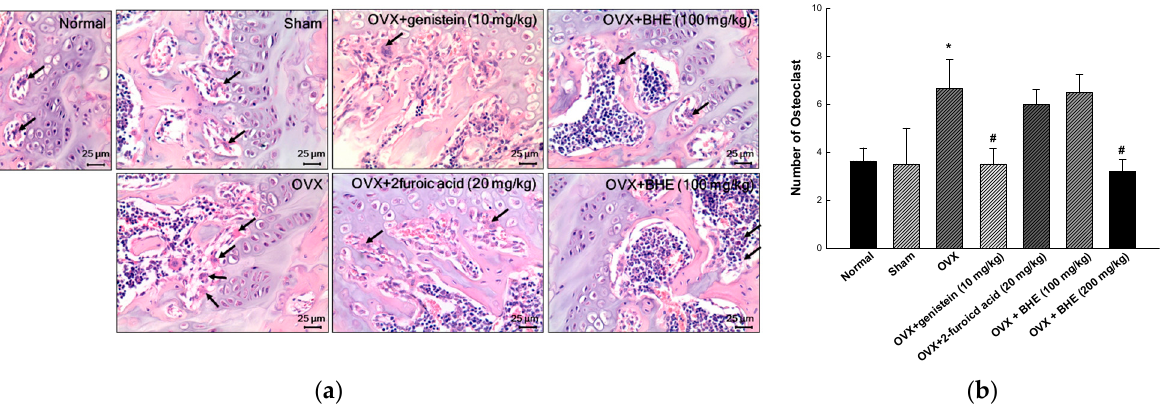
Figure 2. Effects of Benincasa hispida extracts (BHE, HR1901-W) on osteoclast in histological features of the representative metaphysis of a femur. ( a ) Giant hyper-nucleated osteoclast (arrowhead) within a histological section (H&E staining) and ( b ) number of osteoclasts. All values are expressed as the mean ± standard error of the mean (SEM). * p < 0.05 vs. sham group; # p < 0.05 vs. OVX group.